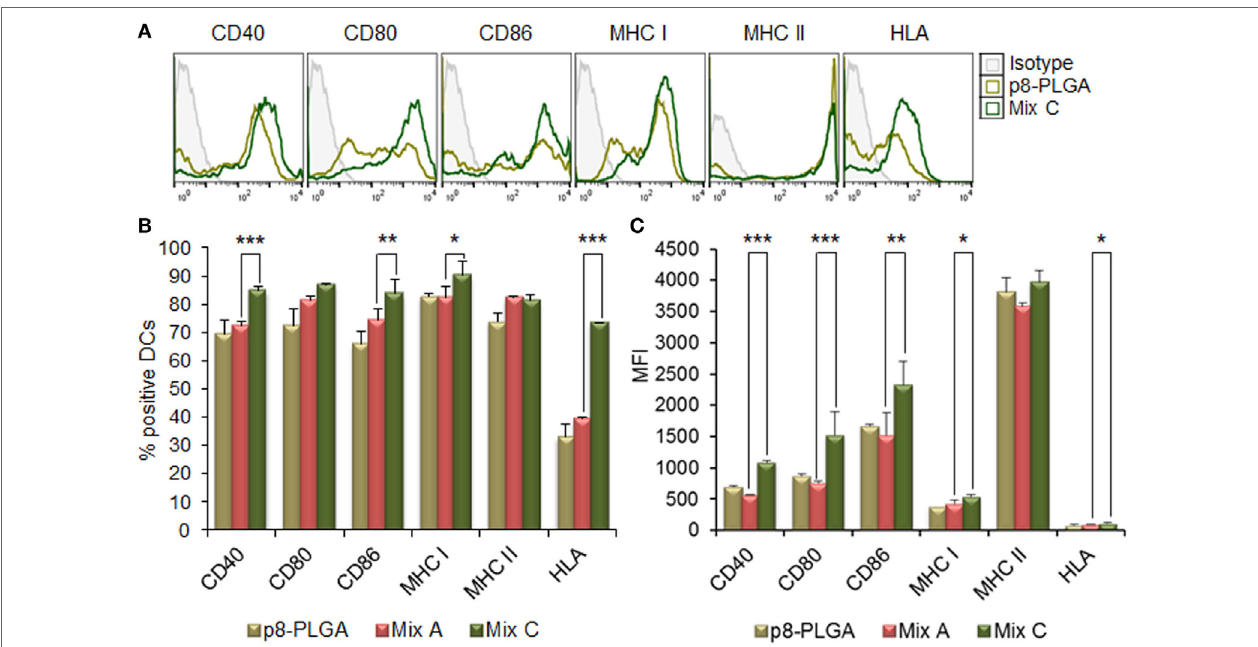
FigUre 4 | Surface modification of peptide-based poly(lactic- co -glycolic) acid (PLGA) nanoformulations with p8 also enhanced the maturation of dendritic cells (DCs) from HLA A2.1 transgenic mice. DCs were cultured for 24 h upon stimulation with the mix of p8-PLGA-chCPAp, p8-PLGA-chH1p, and p8-PLGA-KMP-11p nanoformulations (mix C) or PLGA nanoparticles surface modified with p8. (a) Representative histogram plots of CD40, CD80, CD86, major histocompatibility complex (MHC) class I, and class II molecules levels. (B) Diagram demonstrating the percentage (%) of DCs expressing the co-stimulatory and MHC class I and class II molecules. (c) Diagram demonstrating the mean fluorescence index (MFI) of DCs expressing the co-stimulatory and MHC class I and class II molecules. Results are expressed as the mean ± SD of three independent experiments. Significant differences are indicated by * p < 0.05, ** p < 0.01, or *** p <